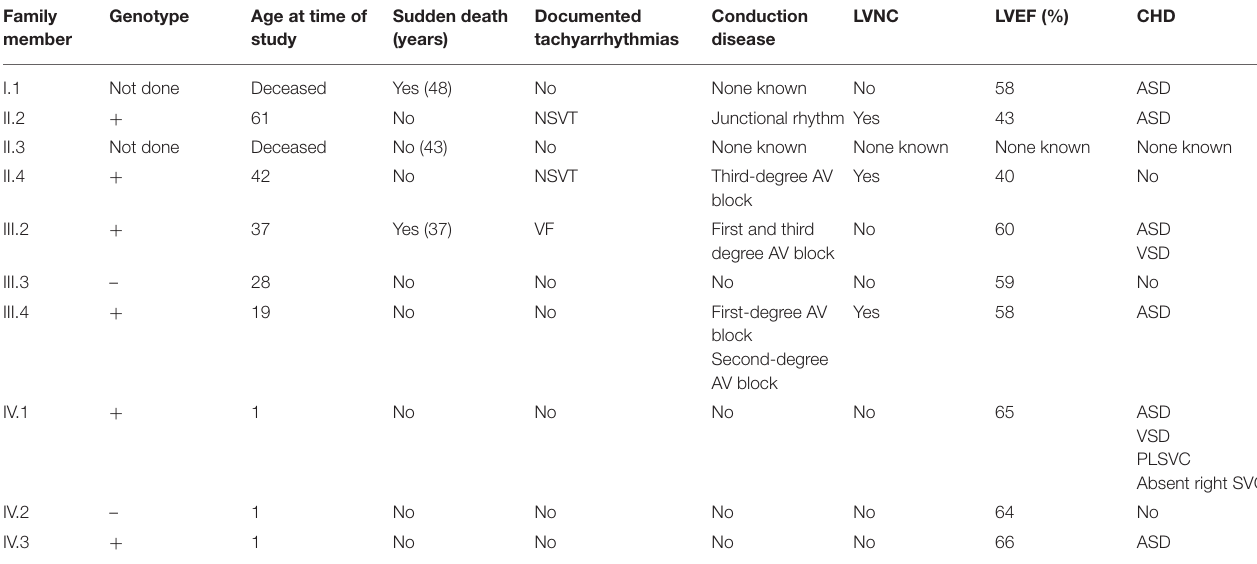
TABLE 1 | Clinical phenotype of family members. Family member